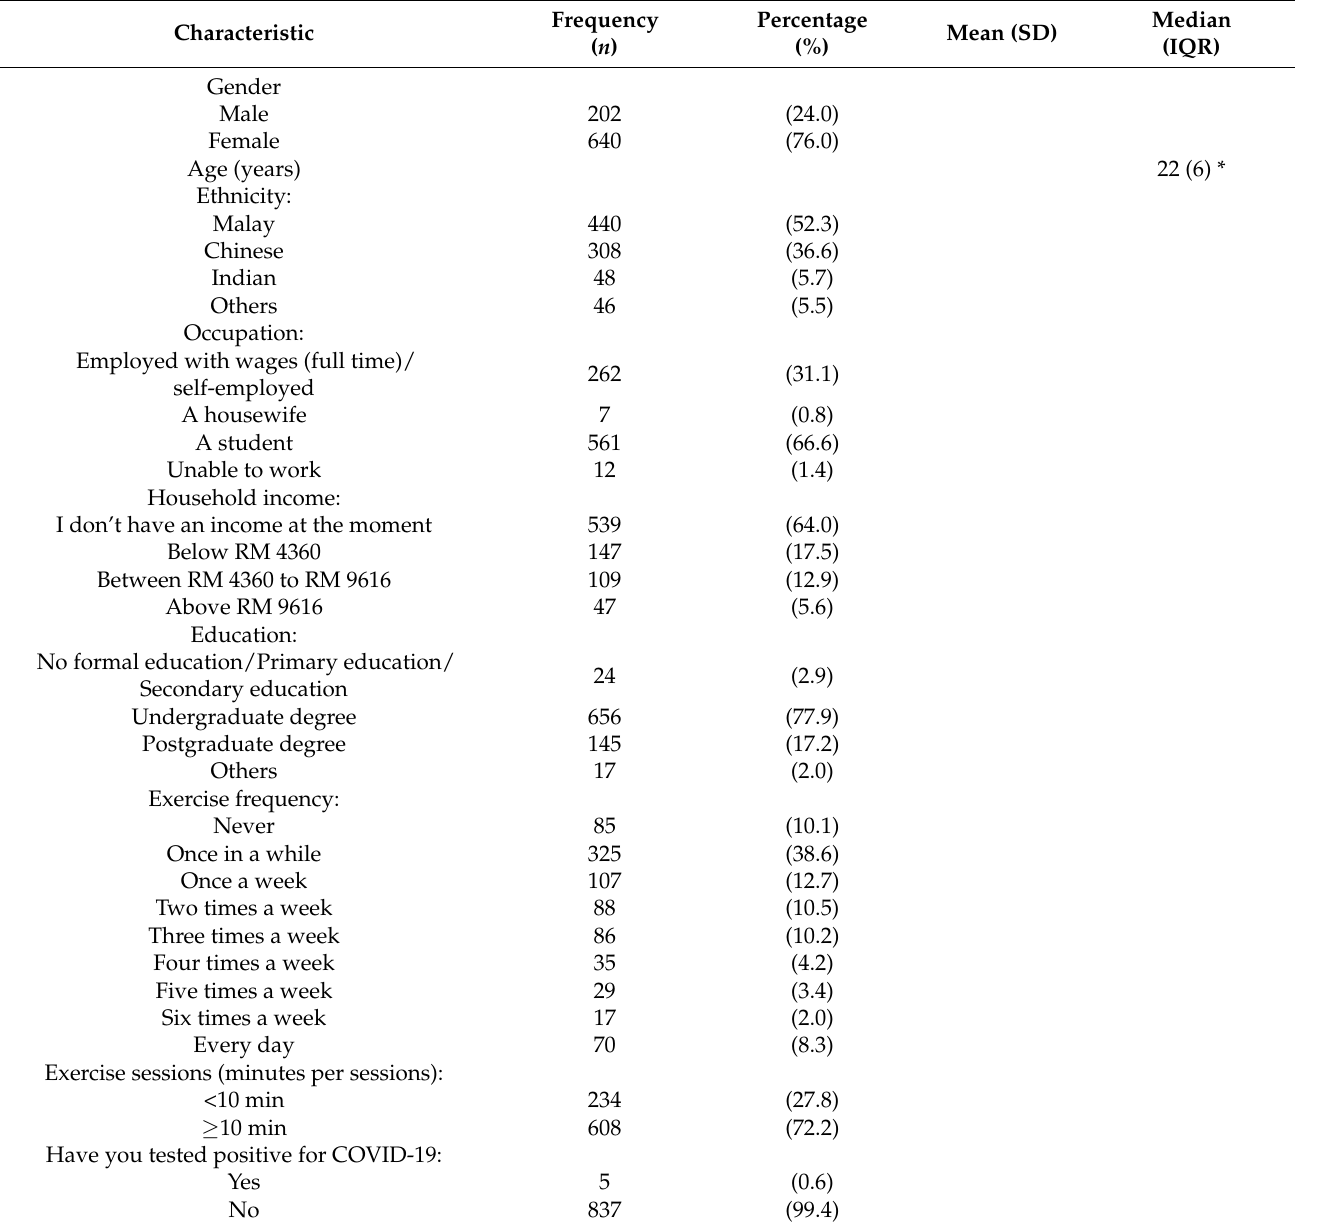
Table 1. Sociodemographic characteristics of respondents, ( n =